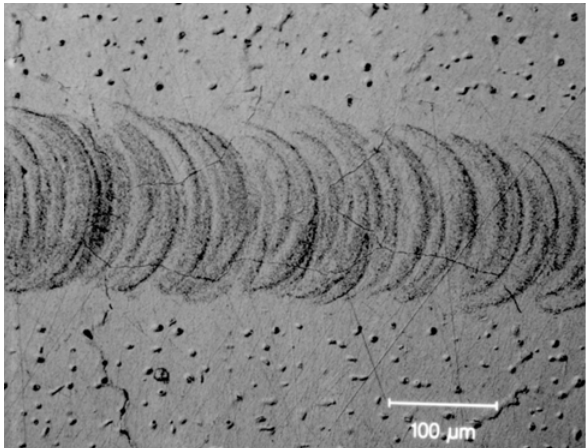
Figure 3. Al – 2 wt% Cu sample remelted with a laser scanning speed of 5 mm/s and power of 1300 W. The region shown has a high density of fissures.